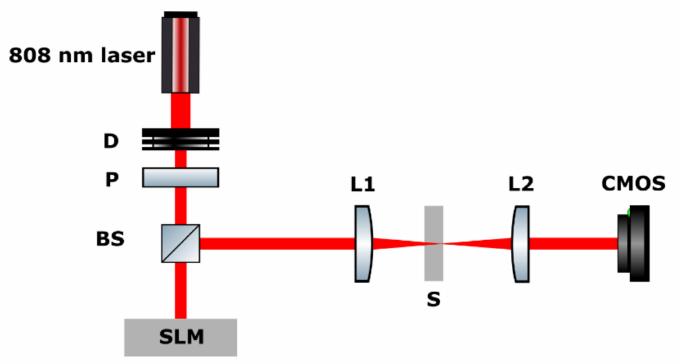
Figure 6. Schematic of the experimental setup. Letters represent: D: Diaphragm; P: Polarizer; BS: Beamsplitter; L1, L2: Plano-convex lens; S: